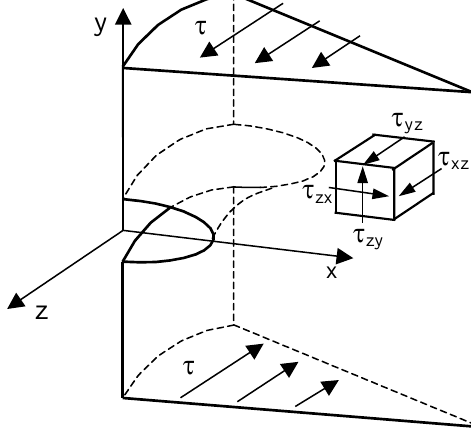
Figura 1: Componente assialsimmetrico indebolito da un intaglio circonferenziale e soggetto a taglio antiplanare. Intagli di forma semiellittica